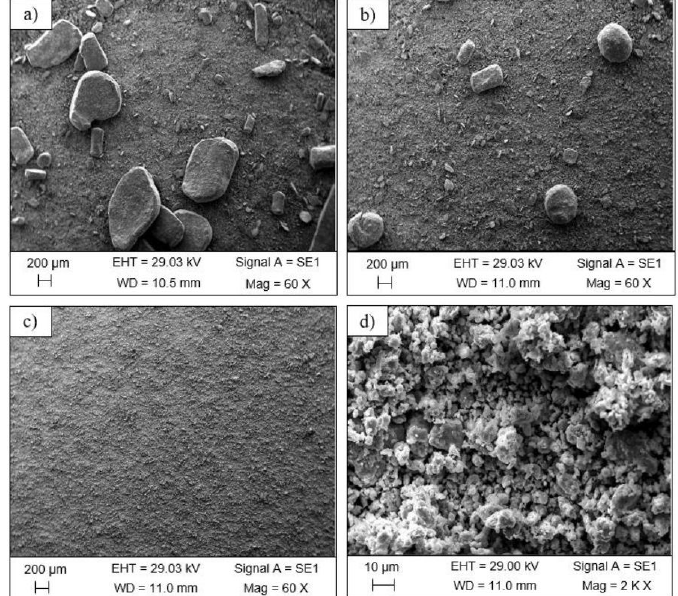
C addition and milled for: (a) 4 hours (b) 8 hours (c) 12 hours 2